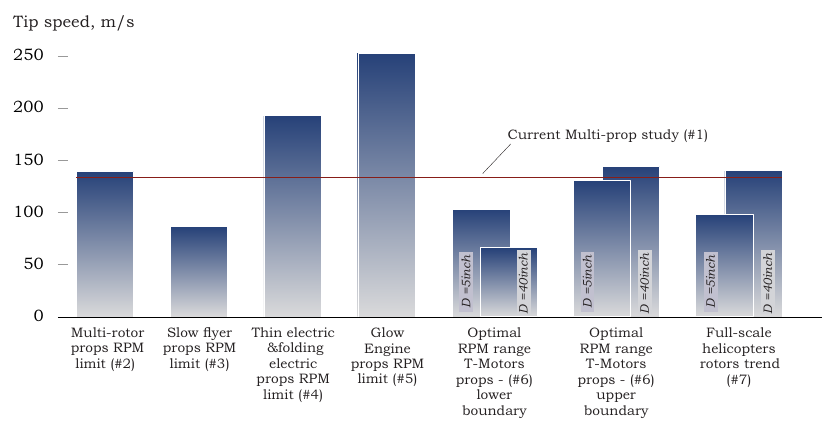
Figure 3. Propellers tip velocity for different vehicle types.